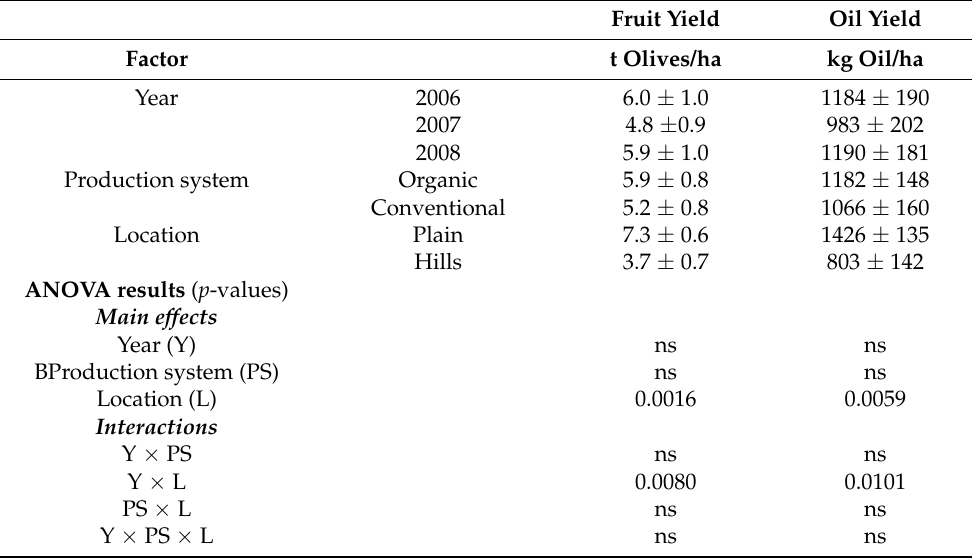
Table 2. Effect of, and interaction between, harvest year (2006, 2007, 2008), production system (organic versus conventional) and location of fields (plain versus foot hills) on